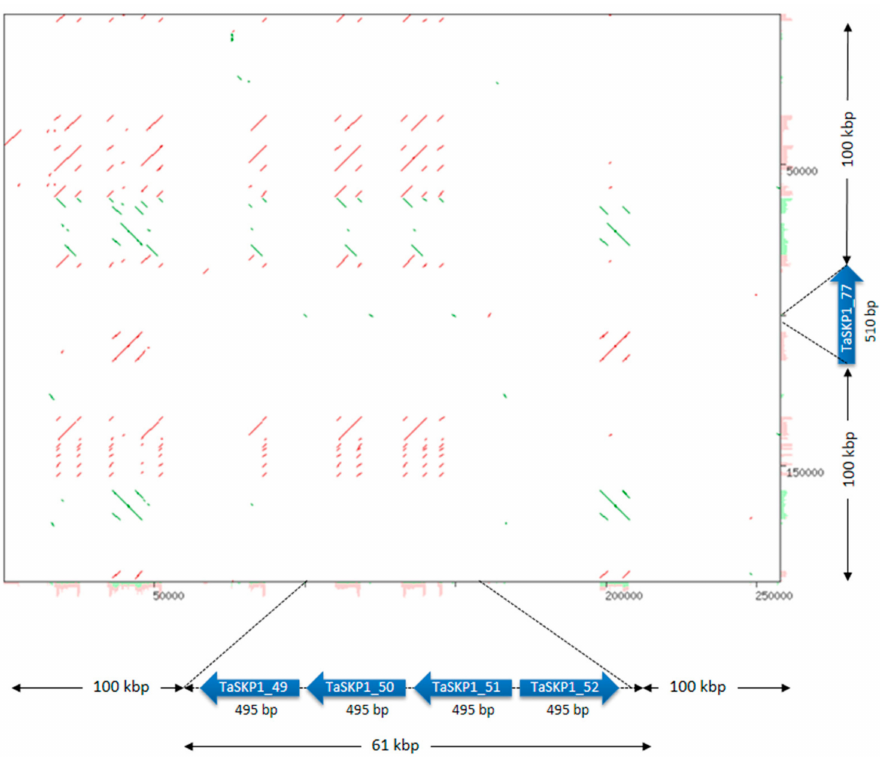
Figure 3. Dotplot showing an example of duplications between two genomic regions containing TaSKP1_49, TaSKP1_50, TaSKP1_51 and TaSKP1_52 genes and TaSKP1_74 and TaSKP1_75 genes. The red dots correspond to the sense duplications and the green dots to the antisense duplications.